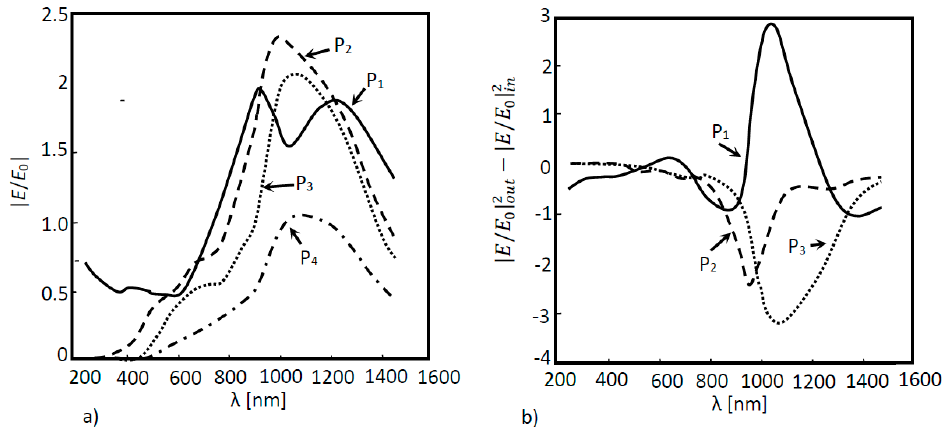
Figure 10. ( a ) Optical response of the simulated 3D a-Si solar cell structure as a function of the wavelength with a nanoantenna within the solar cell and ( b ) Absorption curves of the simulated 3D a-Si solar cell structure as a function of the wavelength.